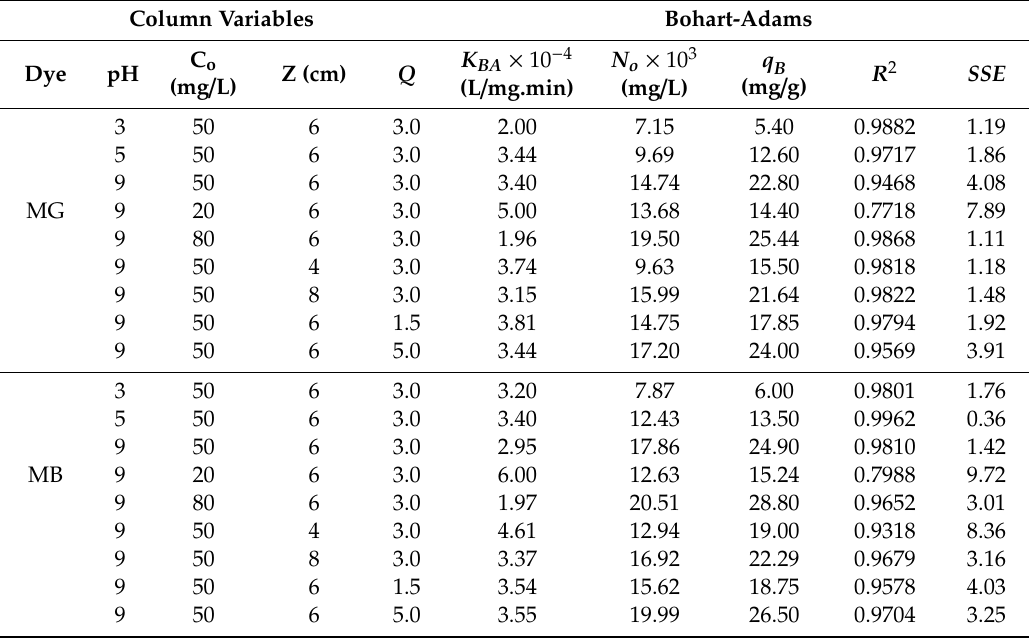
Table 6. Bohart-Adams model constants and statistical parameters for MG and MB adsorption by T-PAA at di ff erent column conditions. Column